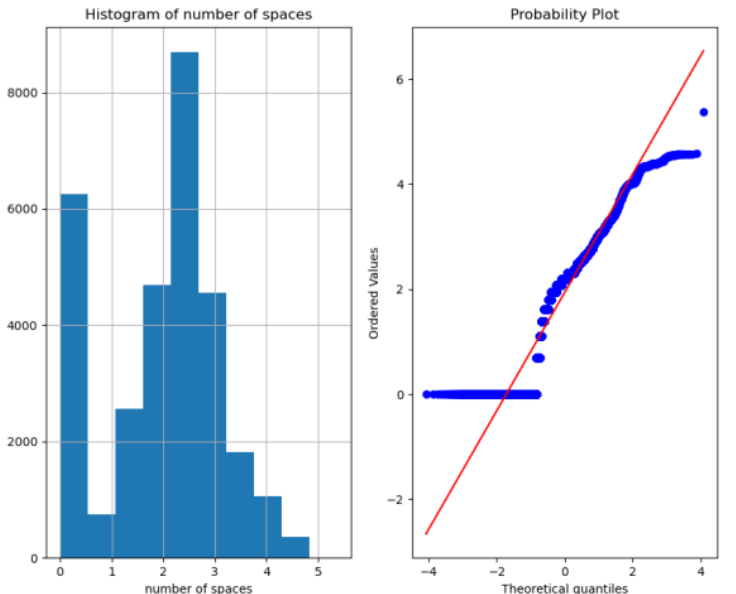
Figure 12. Q-Q plot of feature 8 by log transformation. After doing Box-Cox transformation on the distribution of the number of spaces, the sample frequency histogram ( left ) and Q-Q plot ( right ) are plotted. In the Q-Q plot (right), the horizontal coordinate indicates the normal distribution quantile and the vertical coordinate indicates the data quantile. It is obvious that the feature of the number of spaces does not follow a normal distribution.